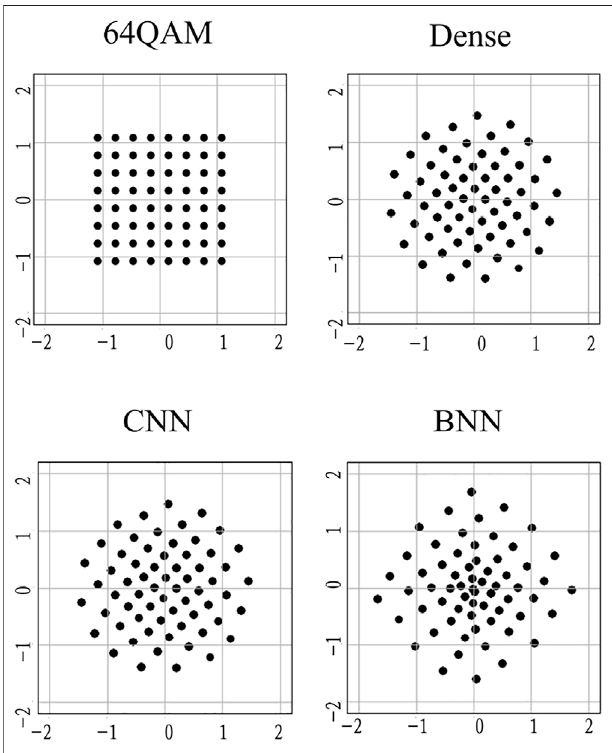
FIGURE 9 | Constellation diagrams over Rayleigh under symbol.